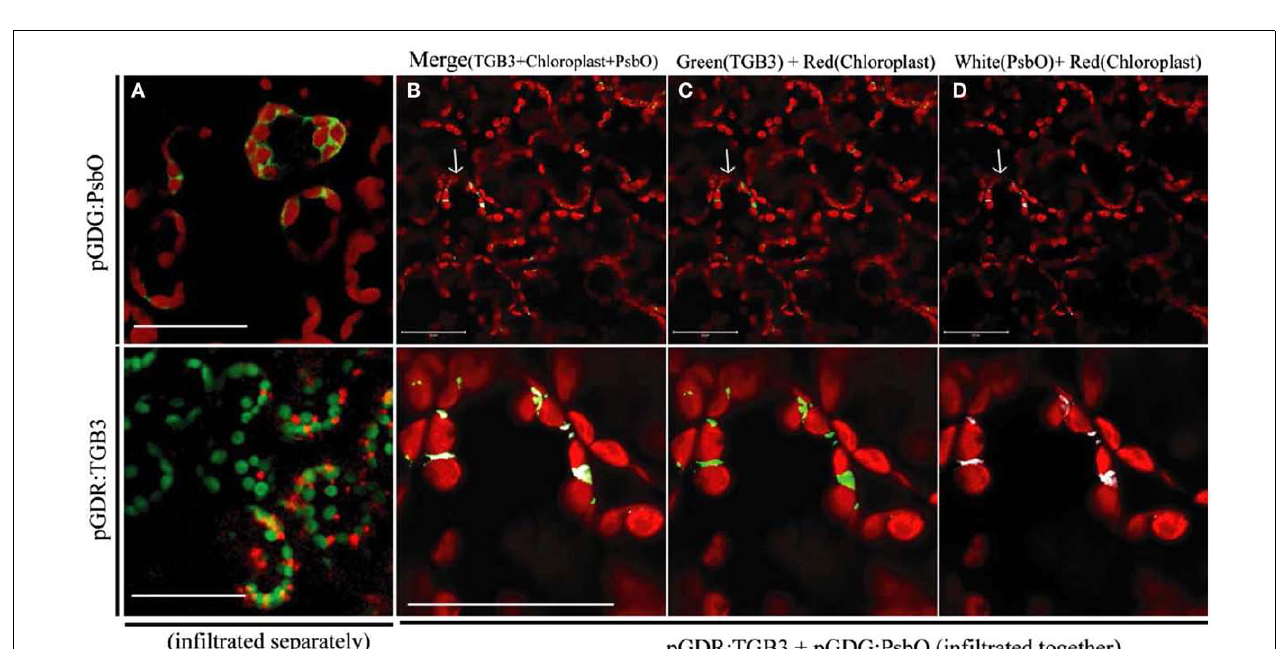
upper row shows multiple cells with typical morphology of the mesophyll layer, and red chloroplast autofluorescence.The lower row shows a magnified image of the area indicated by an arrow in the upper panel. (B) Merge of DsRed:TGB3 (shown as green) with GFP:PsbO (shown as white) and chloroplast autofluorescence (red). (C) DsRed:TGB3 (green) and chloroplast autofluorescence (red). (D) GFP:PsbO (white) and chloroplast autofluorescence (red). Note co-localization of DsRedD:TGB3 and GFP:PsbO at areas where chloroplasts appear to be in close contact. Scale bar = 50 µ